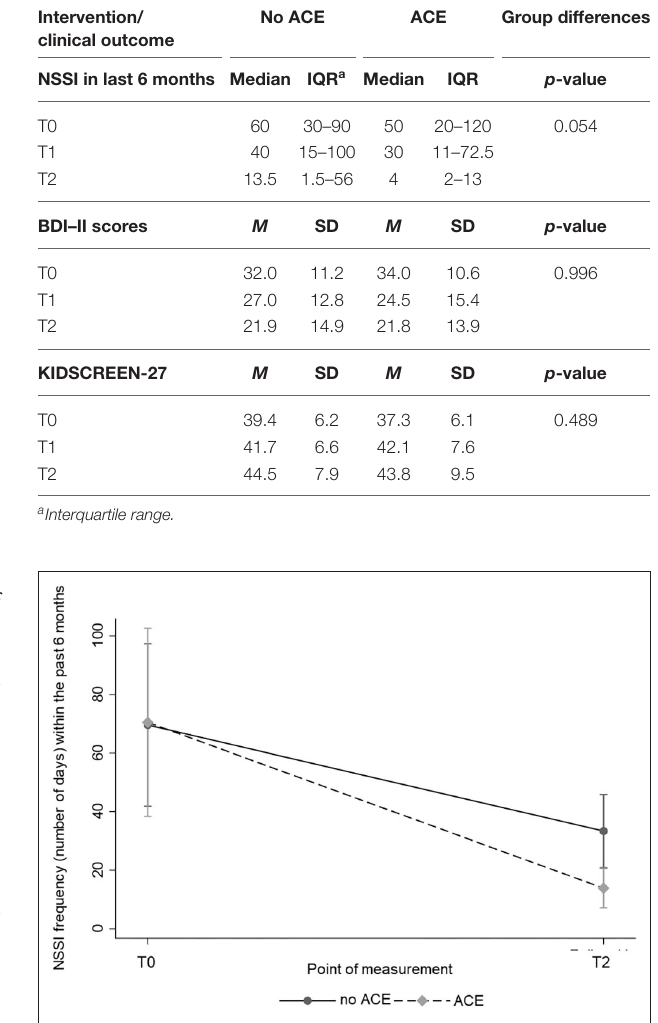
FIGURE 1 | Course of NSSI frequencies (number of days) within the past 6 months by ACE over